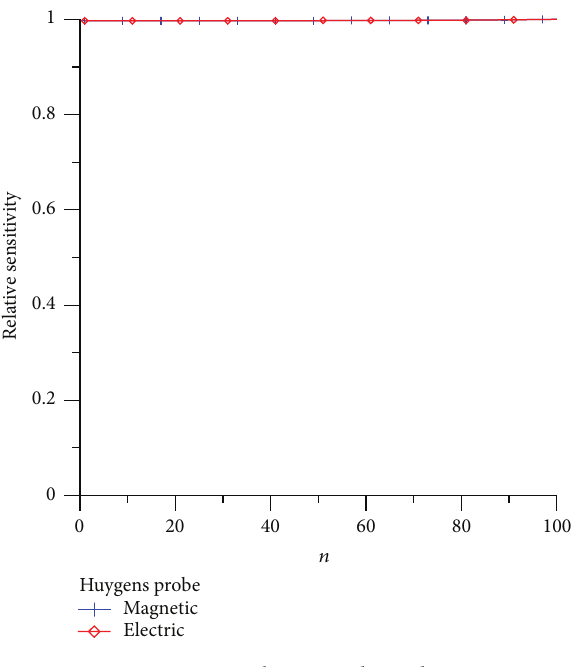
Figure 6: Huygens probe, external case, 𝑘𝑟